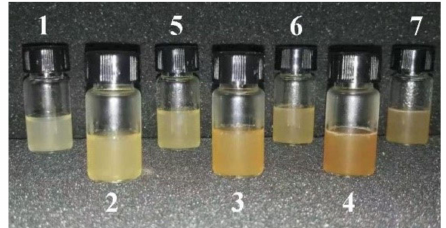
Figure 1. SF ink and SP composite ink prepared by G-SF, G-WS, and G-ILS. The number of SF ink and SP composite ink in the figure are (1) G-SF, (2) G-SF/WS (10%), (3) G-SF/WS (20%), (4) G-SF/WS (30%), (5) G-SF/ILS (10%), (6) G-SF/ILS (20%), and (7) G-SF/ILS (30%). Table 1. Composition of SF ink and SP composite ink (total volume 20 mL).